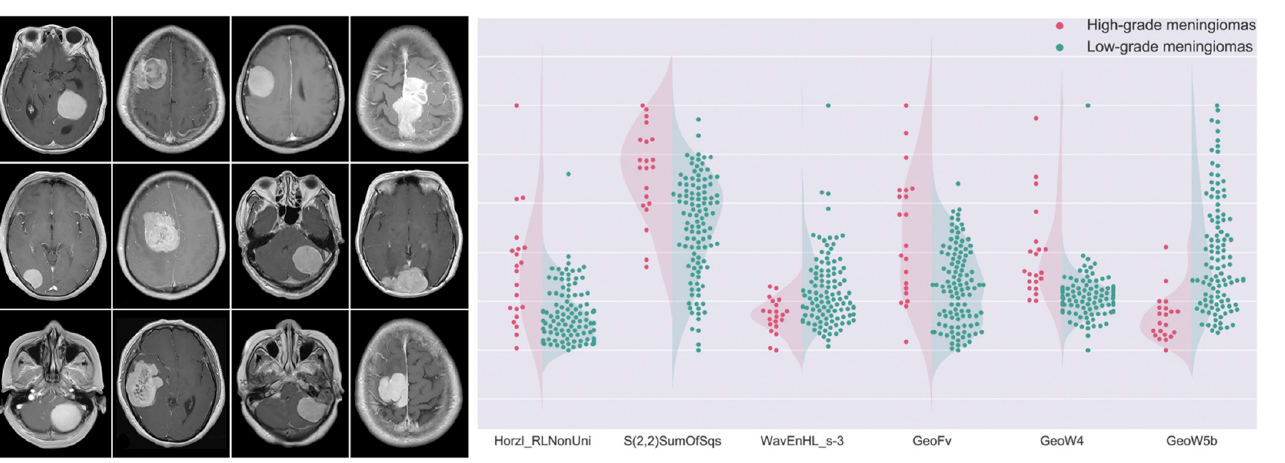
Figure 4. MR images depicting differences in meningioma textural heterogeneity and morphology. The graph presents patient distributions for six radiomics features. High-grade meningiomas are represented in red, while green dots symbolize low-grade lesions. These selected features were sig- nificantly different between the two groups. Adapted from Ref. [21], under the terms of the Creative Commons Attribution-NonCommercial 4.0 License.